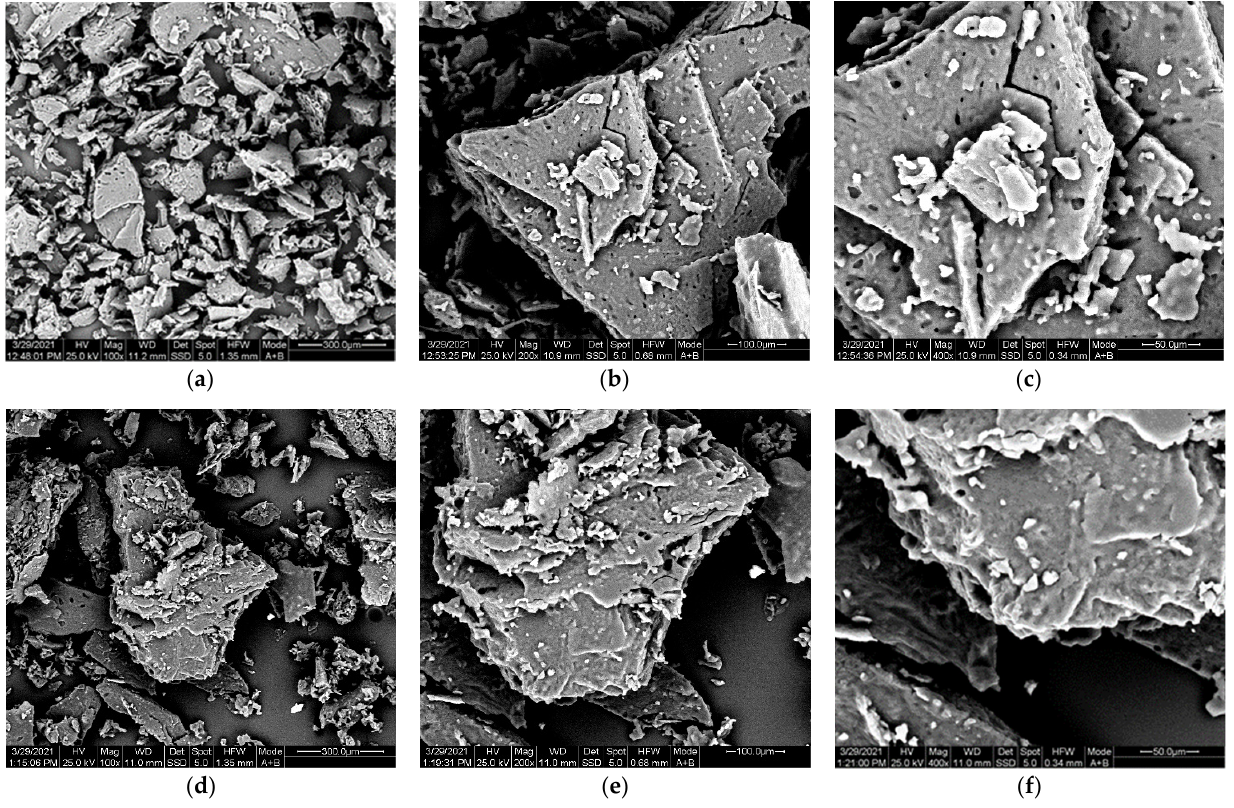
Figure 9. SEM images of R2_165_6_20 samples ( a – c ) and PA612_168_5_20 samples ( d – f ). Turning to the end-group analysis the primary data are given graphically in Figure